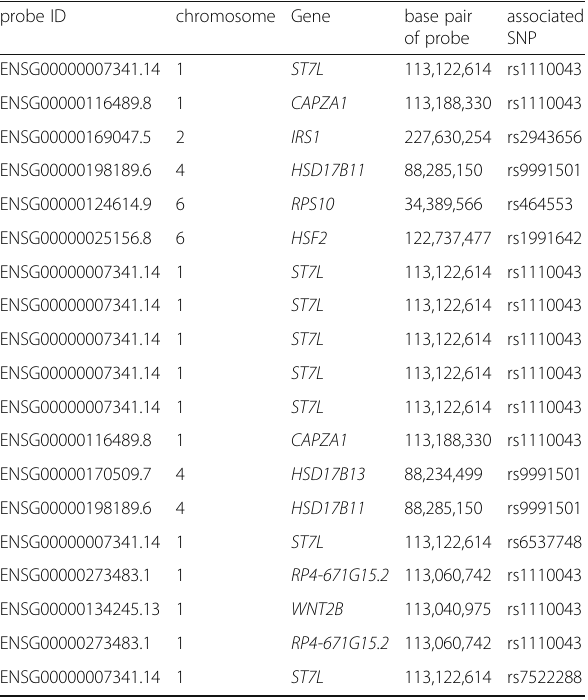
Table 3 SMR of GTEx eQTLs and lean mass GWAS, results for all tissue